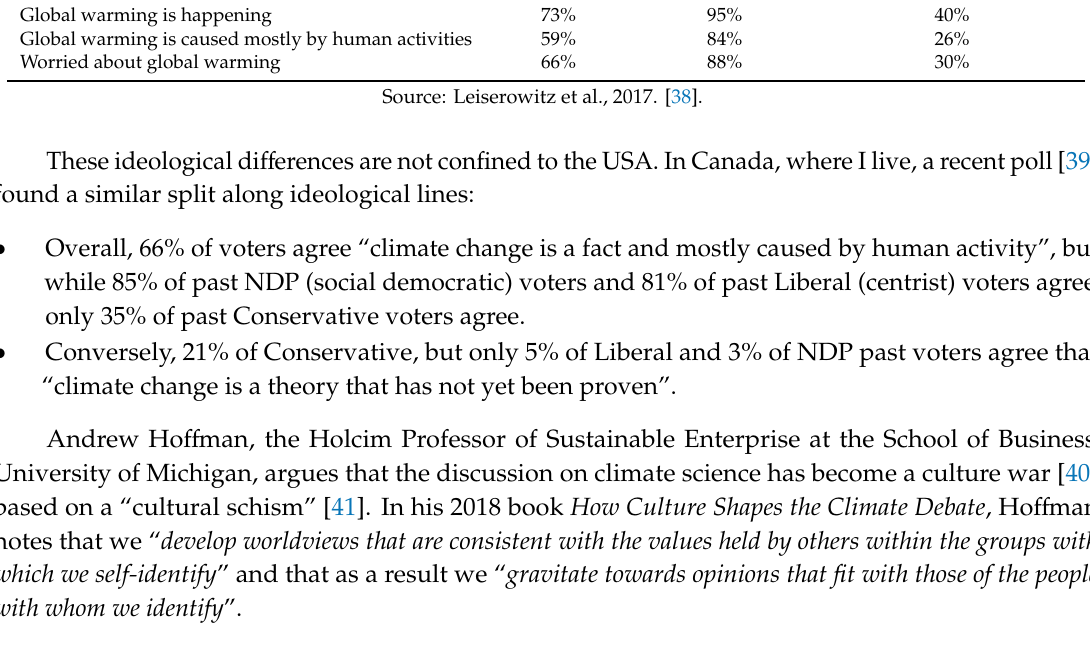
Table 2. Views on climate change and political ideology, USA, October 2017. Overall Liberal Democrat Conservative Republican Global warming is happening 73% 95% 40% Global warming is caused mostly by human activities 59% 84% 26% Worried about global warming 66% 88% 30% Source: Leiserowitz et al., 2017.